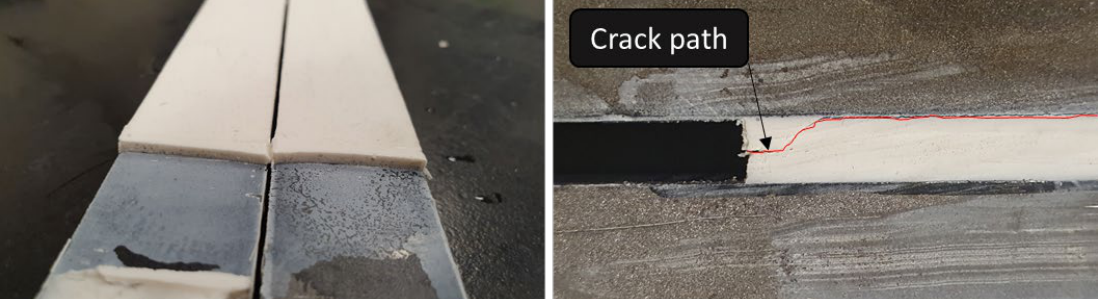
Figure 13. Fracture surface at the crack tip after an LT ( −3 0 °C) mode I fracture test on the ( left ). Typical crack path around the crack tip at 23 °C or 60 °C on the ( right ).